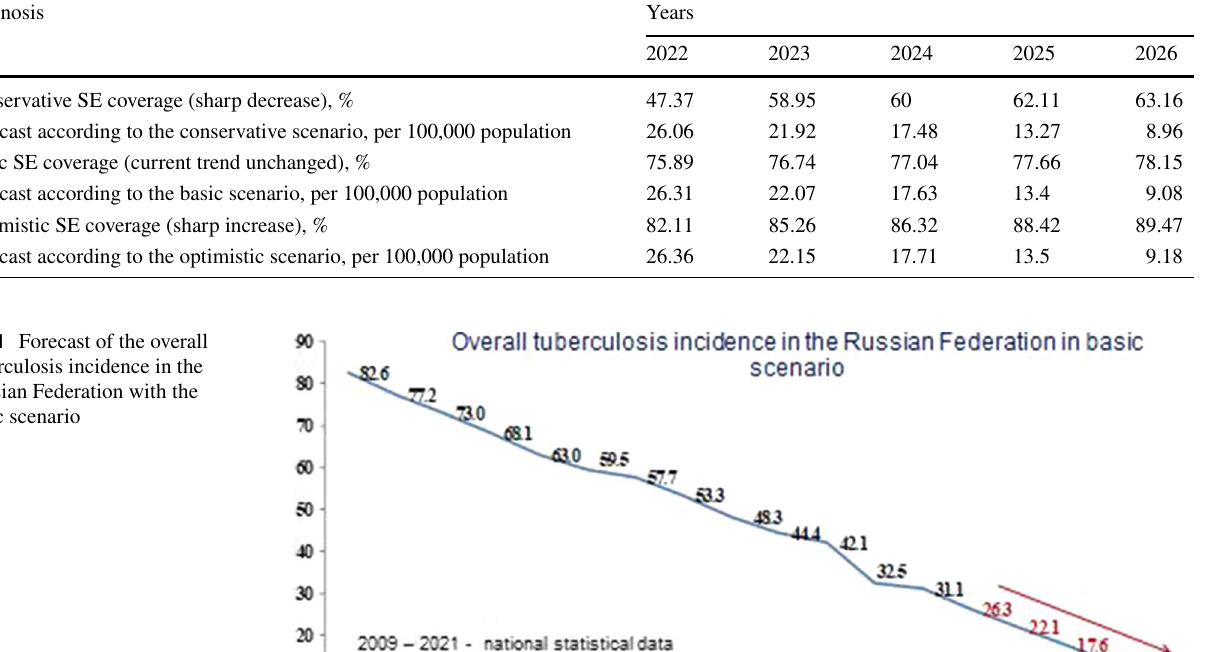
Table 2 Forecast of the overall tuberculosis incidence of in the Russian Federation according to the created scenarios for a 5-year period Prognosis